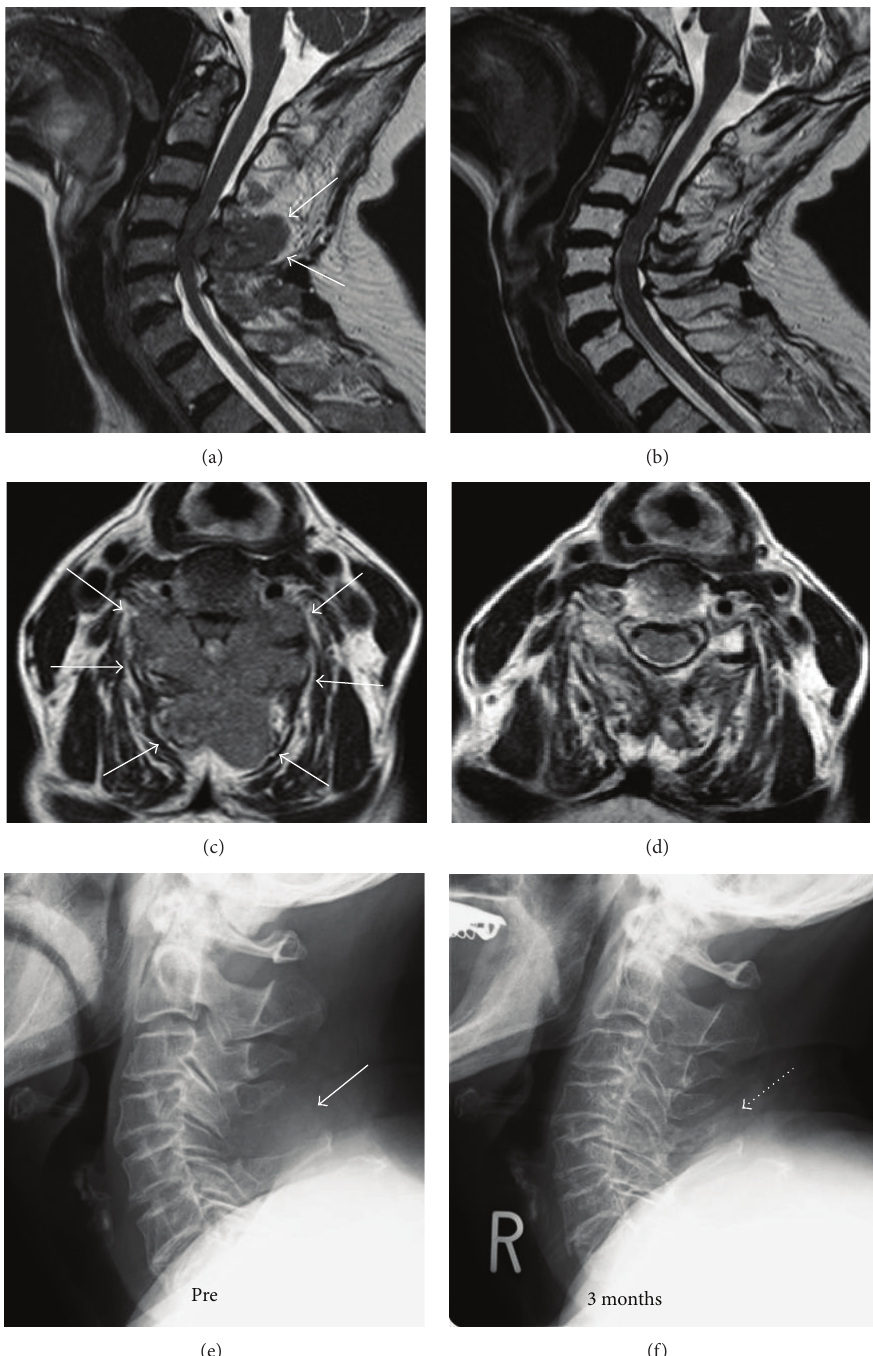
Figure 1: Magnetic resonance images: (a), (b) sagittal views; (c), (d) axial view at the fifth cervical vertebra (C5); and (e), (f) plain radiographs before (a), (c), and (e) and 3 months after (b), (d), and (f) radiotherapy. The arrows (a), (c) indicate the epidural mass involving the spinous process, laminae, and pedicles at C5 and compressing the spinal cord circumferentially. Plain radiographs showing an osteolytic change in the spinous process at C5 (arrow) and subsequent reossification (dashed